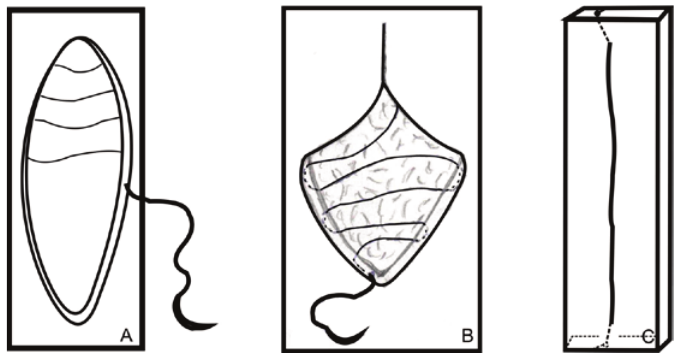
FIGURE 2 - Hidden intradermal suture sequence ( A,B,C ).